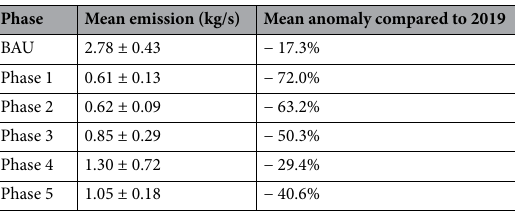
Table 2. Mean top-down NOx emission (± standard deviation) in 2020 and its anomaly with respect to 2019 emissions over a 60 × 60 km 2 region around central Delhi (77.21 E, 28.60